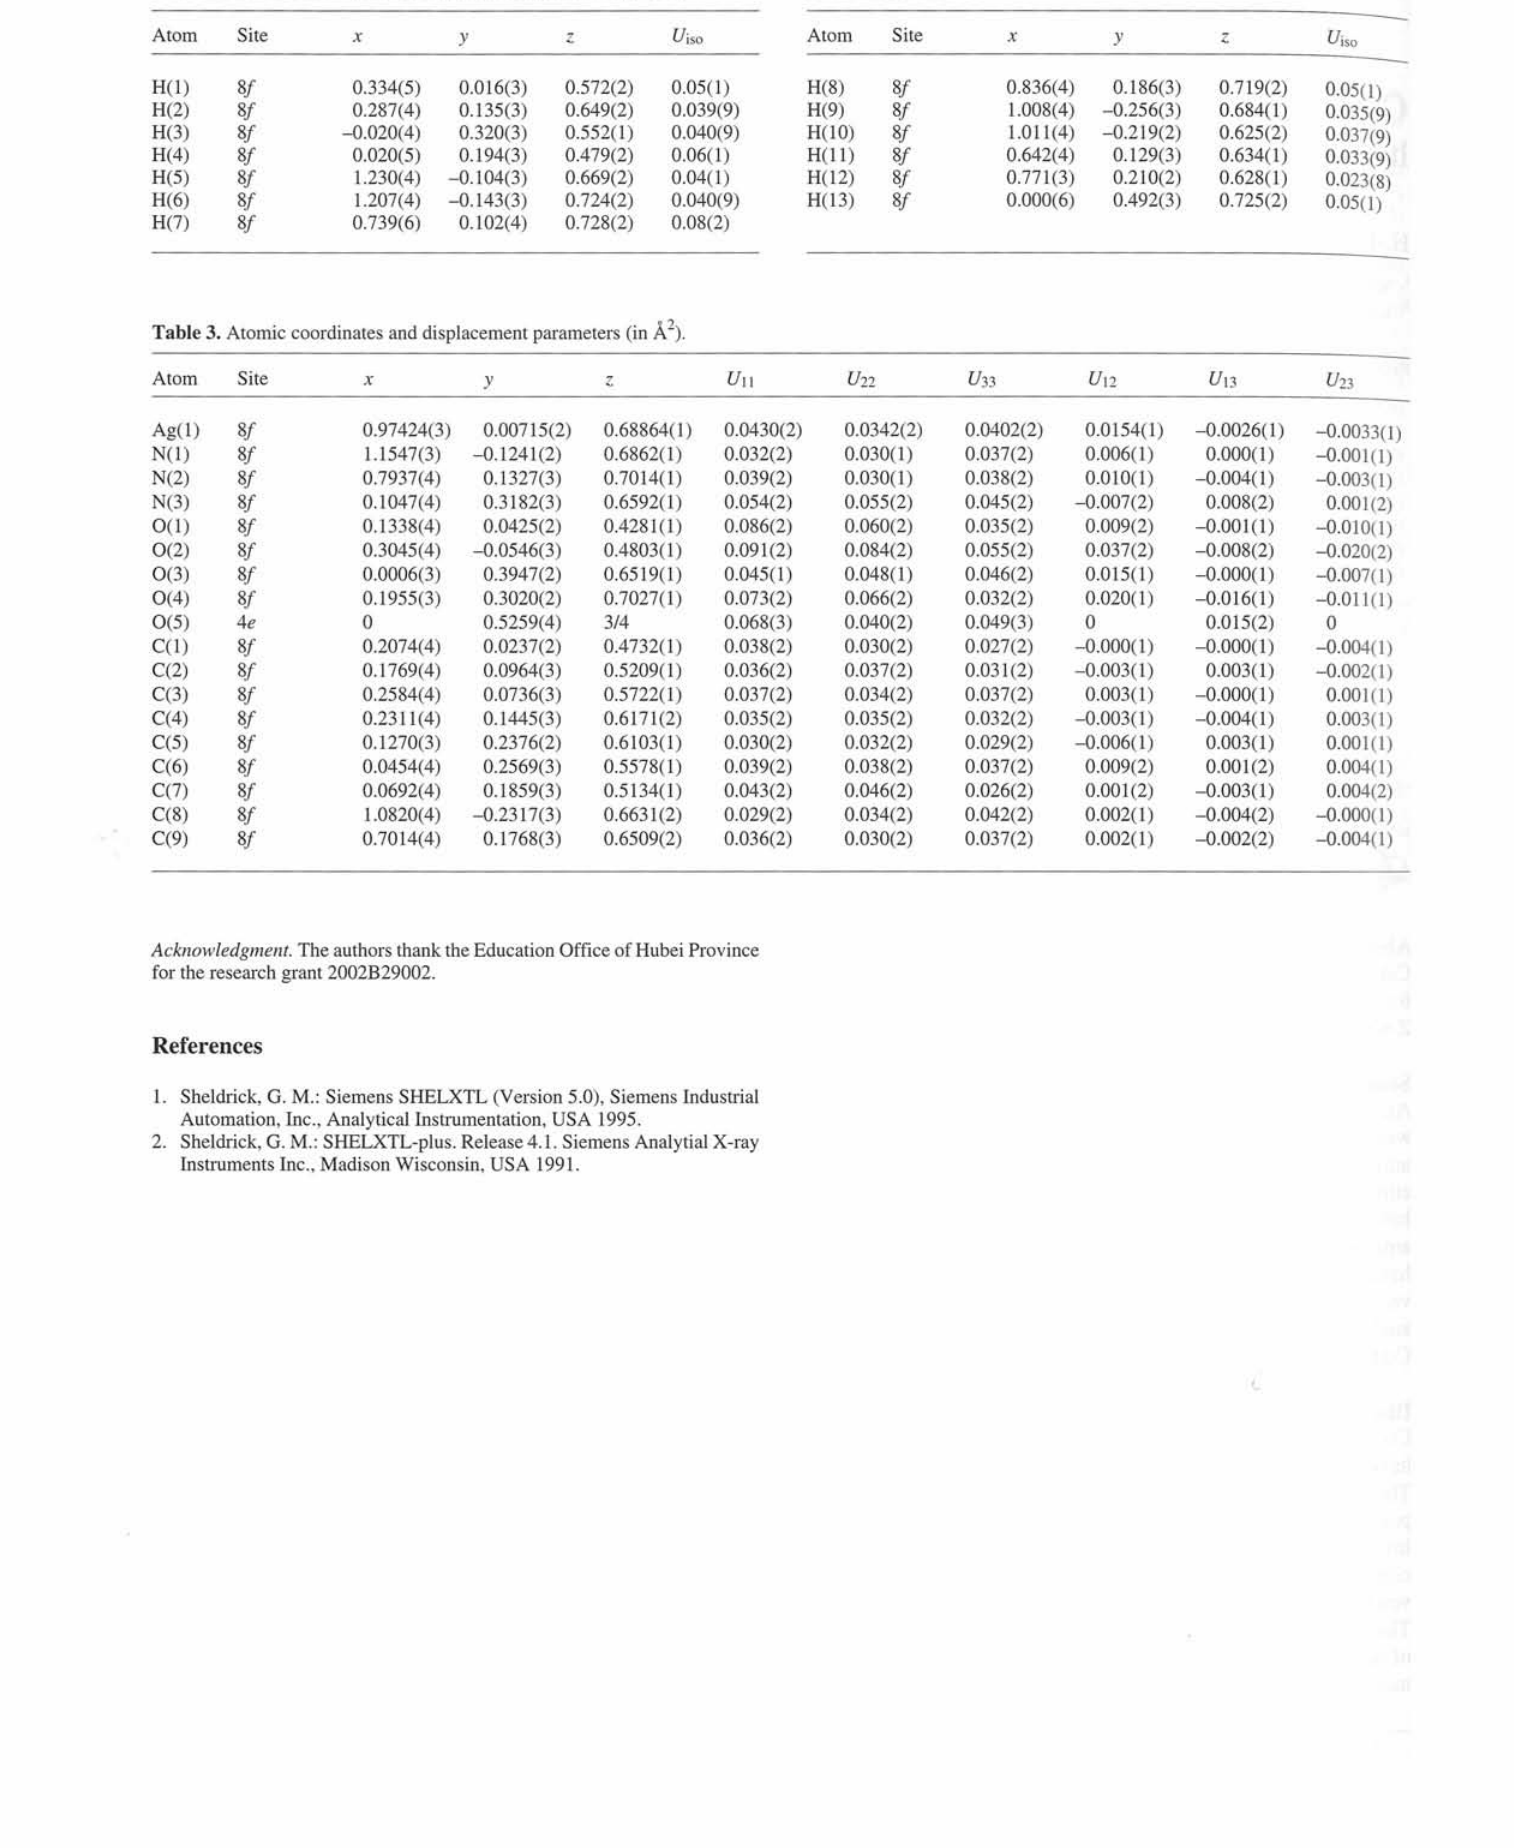
Table 3. Atomic coordinates and displacement parameters (in À 2